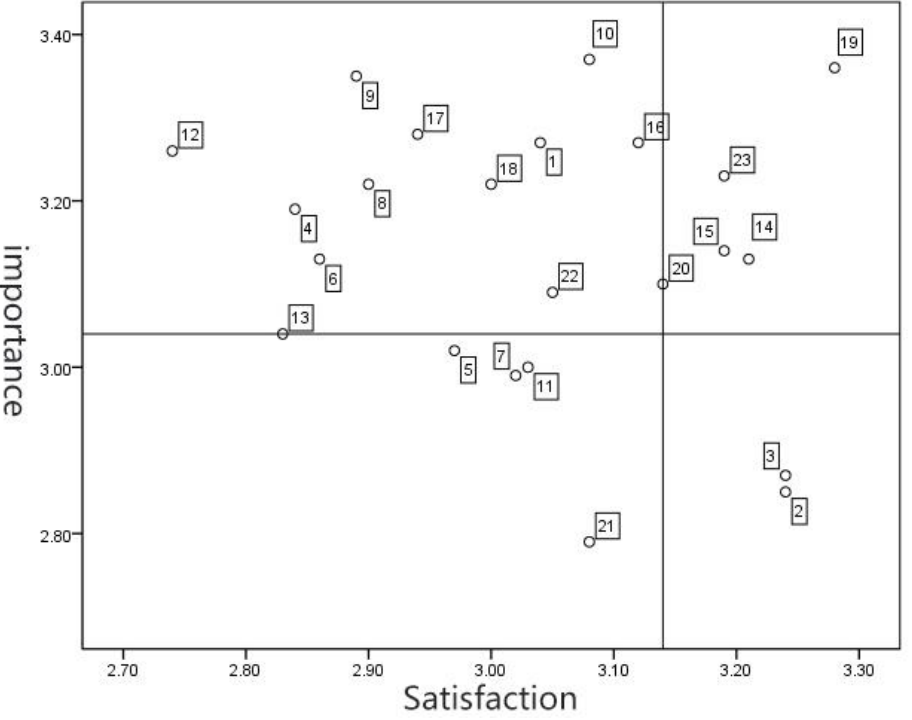
Figure 3. IPA analysis of public fitness equipment experience satisfaction index.